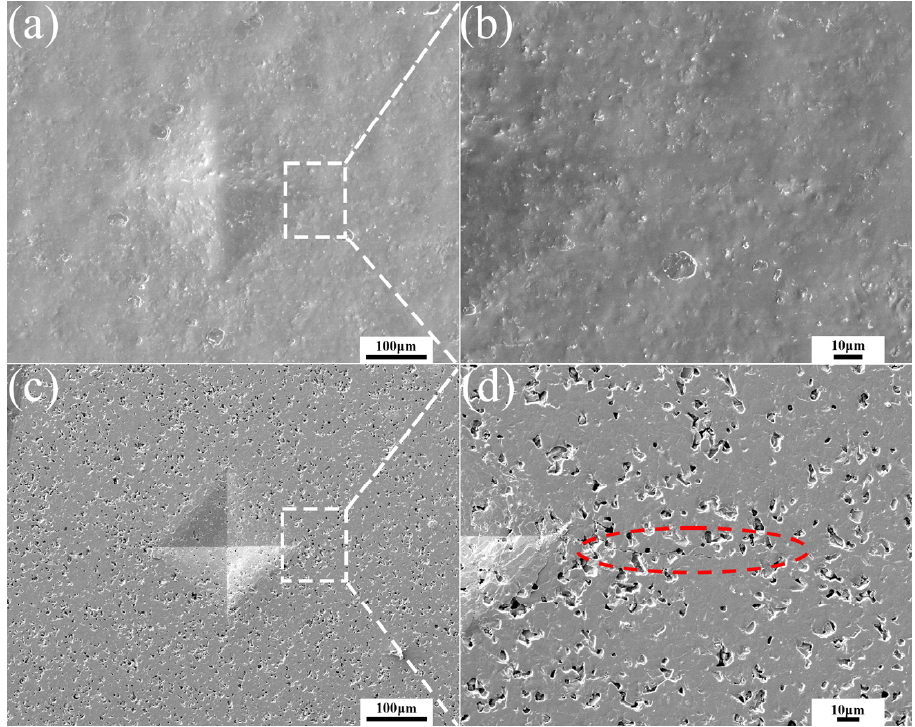
Figure 9. ( a ) B 1s, ( b ) O 1s XPS spectra of the specimen after heat treatment at 700 °C for 30 min.